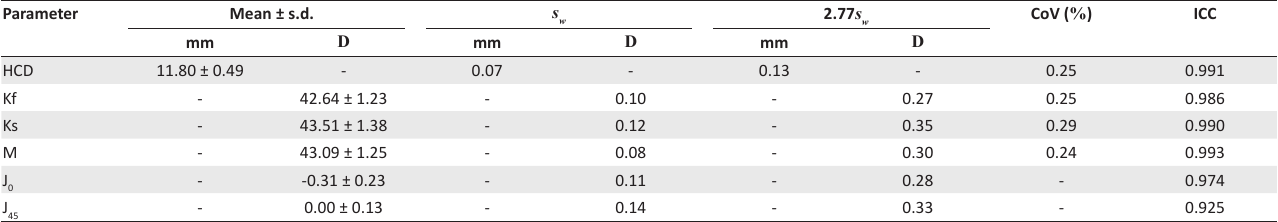
and J using the Oculus Keratograph 4. 0 45